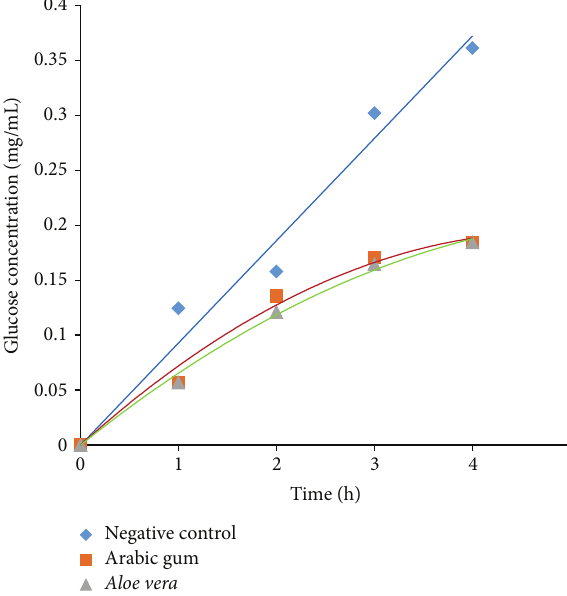
Figure 2: The Lineweaver-Burk plots in the presence and absence of Aloe vera gel. Figure 3: Glucose movement in